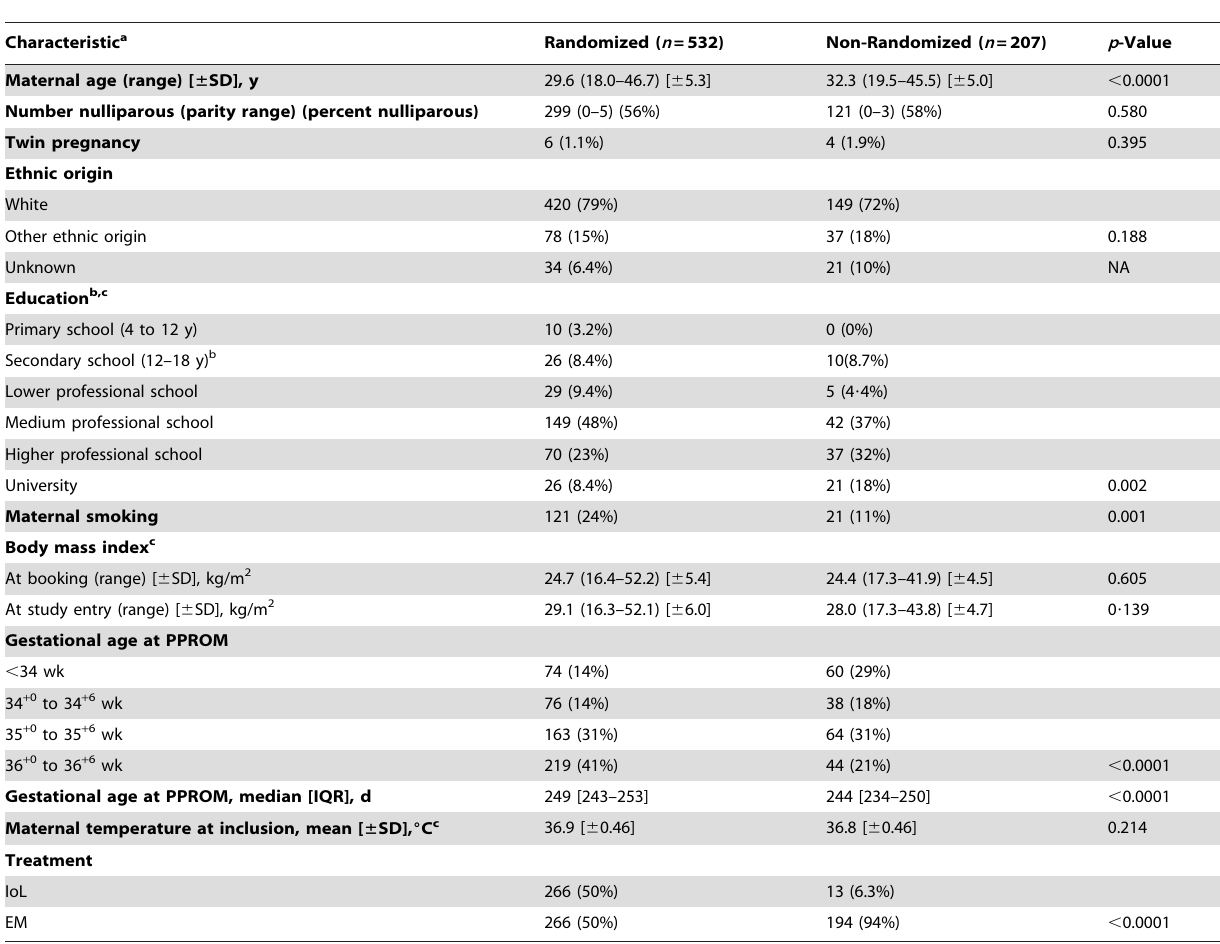
Table 6. Baseline characteristics for randomized versus non-randomized